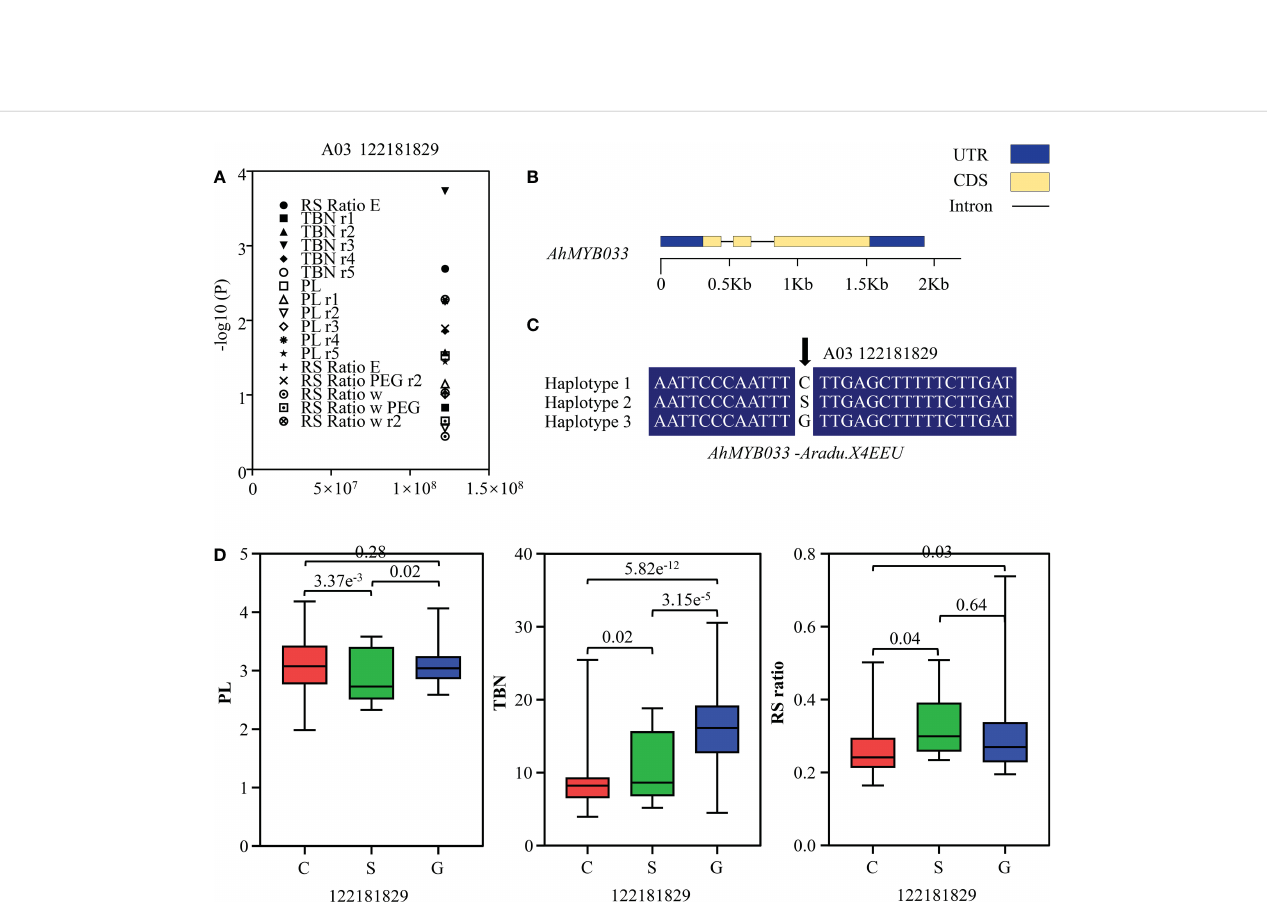
FIGURE 8 Association mapping results and the phenotypes of the polymorphic sites of peanut R2R3-MYBs associated with TBN, PL and RS ratio variation. (A) Association results between TBN/PL/RS ratio and the polymorphisms in AhMYB033 . The vertical and horizontal axes of the scatter plot indicated the P value and the position of the SNP, respectively, and the phenotypes under different environmental treatments were represented by various patterns. (B) Gene structure of AhMYB033 . The yellow box, blue box, and black line were CDS, UTR, and intron, respectively. (C) Sequences of three sites were signi fi cantly associated with TBN, PL and RS ratio variation. (D) Phenotypic comparison of haplotypes of the three associated sites with TBN, PL and RS ratio in fi ve environments of the population. Three different colored boxes were used to indicate the phenotypes of the three haplotypes.